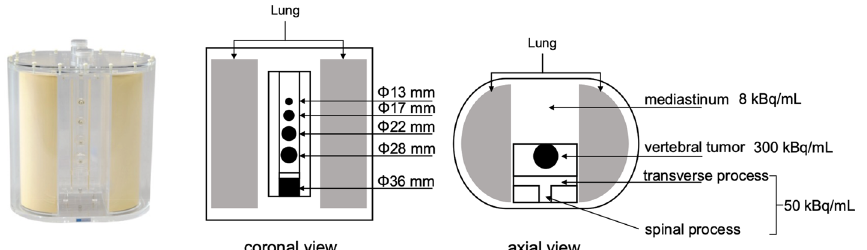
Fig. 1 Overview of the SIM 2 phantom and enclosed radioactivity